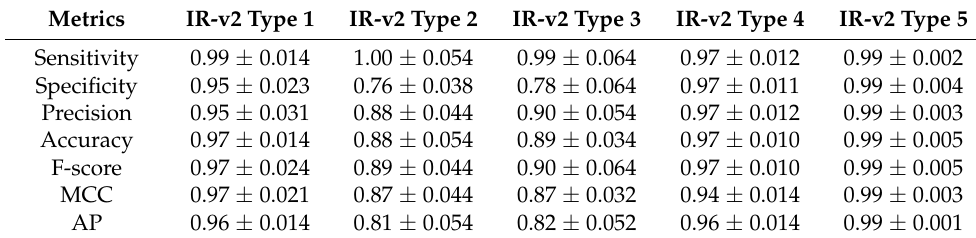
Table 4. Different types of IR-v2 with performance metrics along with